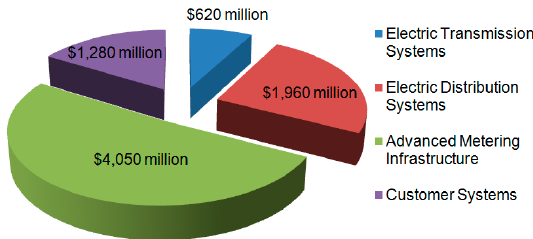
Figure 1. Estimated expenditures of the SGIG programs [14].